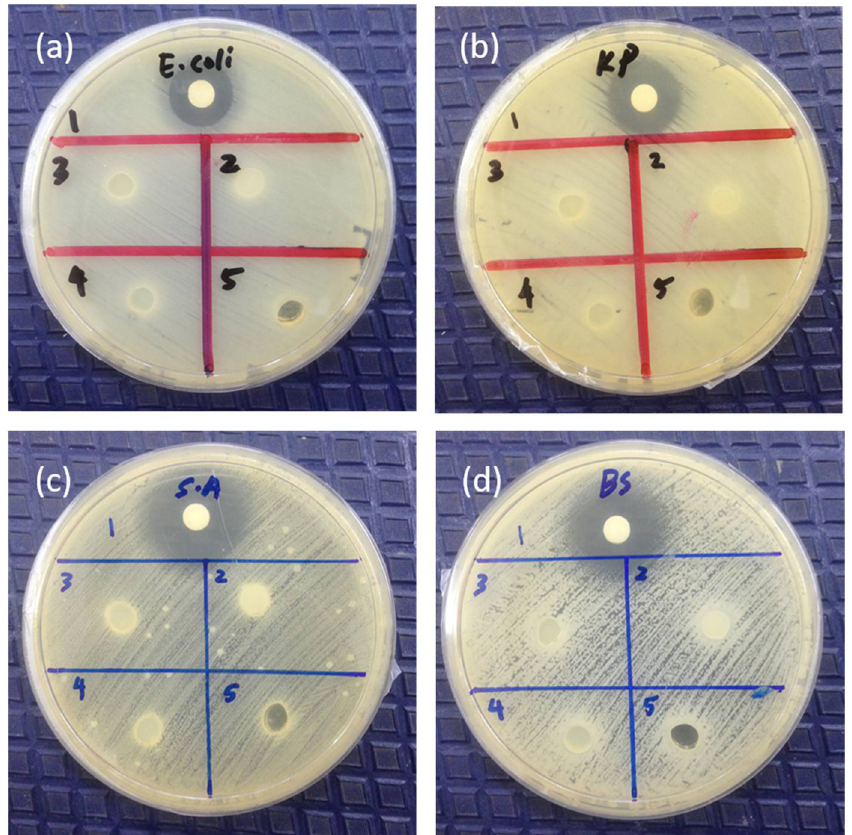
Figure 6. ( a ) Escherichia coli ( E. coli ), ( b ) Klebsiella pneumoniae (KP), ( c ) Staphylococcus aureus (S.A), and ( d ) Bacillus subtilis (BS) shown in the figure. Note: The number refers to samples: (1) penicillin (positive control), (2) GVCO80, (3) GVCO70, (4) GVCO60, and (5) gellan gum (negative control).